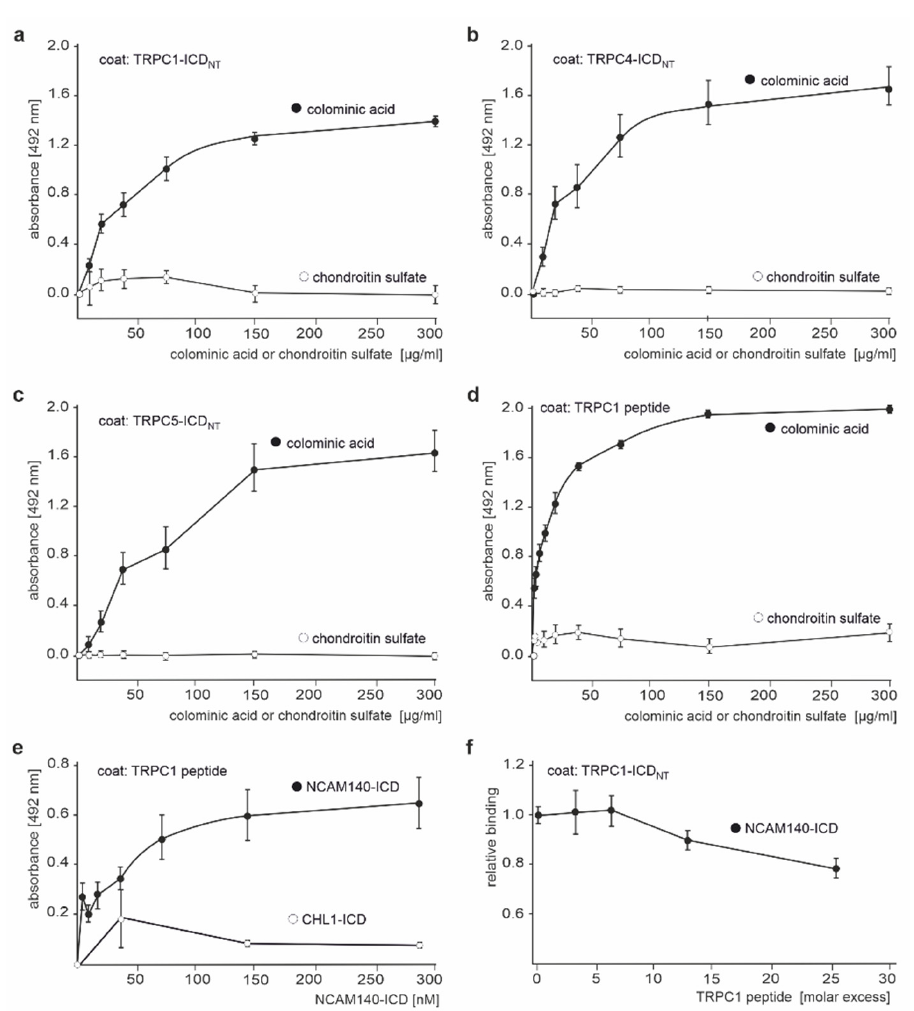
Figure 3. Colominic acid/PSA binds to the N-terminal ICDs of TRPC1, − 4, and − 5, and its binding site overlaps with the binding site of NCAM140-ICD. Recombinant N-terminal ICDs of TRPC1 (TRPC1-ICD NT ) ( a , d ), TRPC4 (TRPC4-ICD NT ) ( b ), TRPC5 (TRPC5-ICD NT ) ( c ), and the TRPC1 peptide ( d ) were substrate-coated and incubated with increasing concentrations of colominic acid/PSA or chondroitin sulfate. Binding was determined by ELISA with antibodies against PSA or chondroitin sulfate. Mean values ± SEM from 3 independent experiments carried out in triplicates are shown. TRPC1 peptide ( e ) or N-terminal TRPC1-ICD (TRPC1-ICD NT ) ( f ) were substrate-coated and incubated with increasing concentrations of NCAM140-ICD or CHL1-ICD ( e ) or with one NCAM140-ICD concentration and different concentrations of TRPC1 peptide ( f ). Binding was determined by ELISA using NCAM antibody P61 ( e , f ) and CHL1 antibody C-18 ( e ). Mean values ± SEM from 3 independent experiments carried out in triplicates are shown.